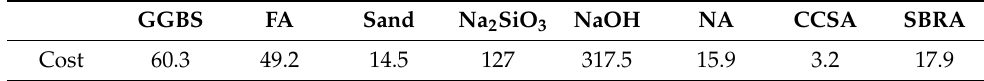
Table 8. Prices of raw materials for concrete (USD/t).